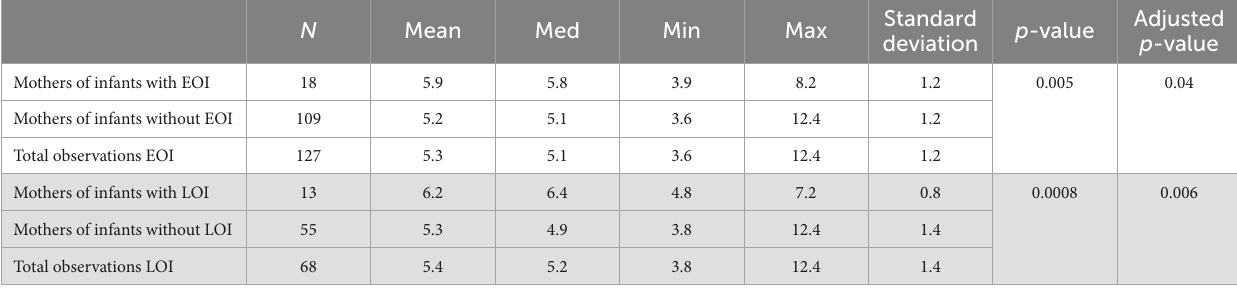
TABLE 5 Maternal blood glucose levels [mmol(l)] of mothers of infants with neonatal infection.